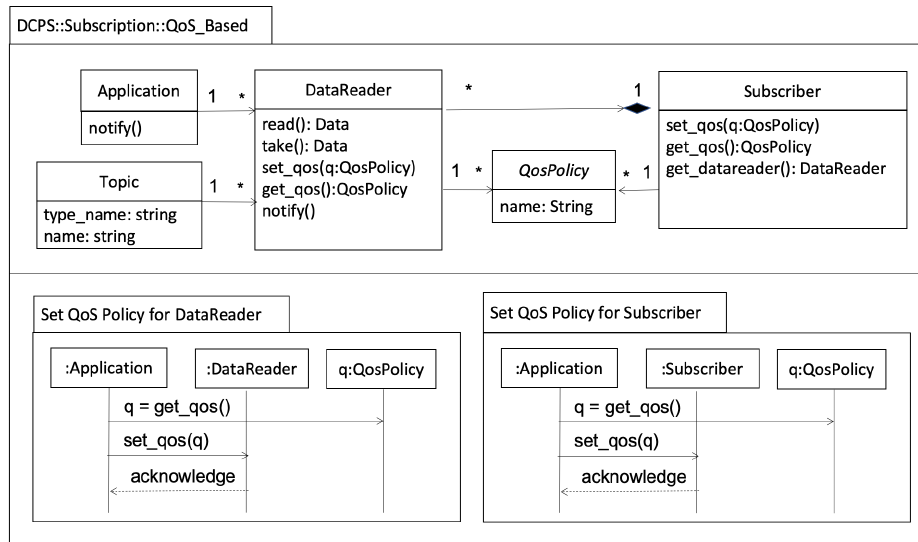
Figure 13. QoS_Based subscription feature.